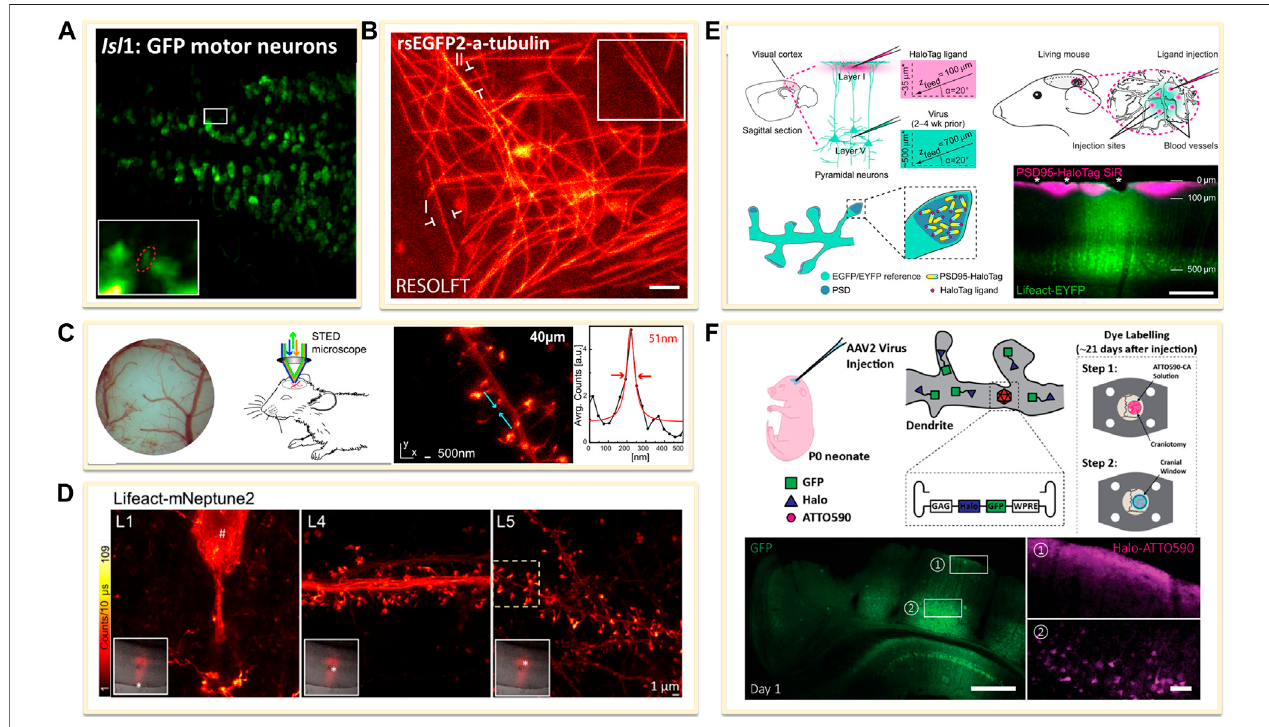
FIGURE 6 | Genetically encoded approaches for in vivo labeling. (A) Transfected dense Isl1:GFP zebra fi sh motor neurons (Li et al., 2020). Scale bar, 20 μ m. Reprinted from Li et al. (2020) with permission from American Association for the Advancement of Science. (B) Drosophila melanogaster ubiquitously expressing rsEGFP2-a-tubulin (Schnorrenberg et al., 2016). Scale bar, 1 μ m. Reprinted from Schnorrenberg et al. (2016) with permission from eLife Sciences. (C) Neurons expressing Lifeact-EYFP by recombinant adeno-associated virus (AAV) infection for STED microscopy (Willig et al., 2014). Reprinted from Willig et al. (2014) with permission from Cell Press. (D) A far red-emitting fl uorescent protein mNeptune2 to expressed with lifeact to label actin fi laments (Wegner et al., 2017). Reprinted from Wegner et al. (2017) with permission from Springer Nature. (E) In vivo labeling process of endogenous PSD95-HaloTag with organic fl uorophores SiR (Masch et